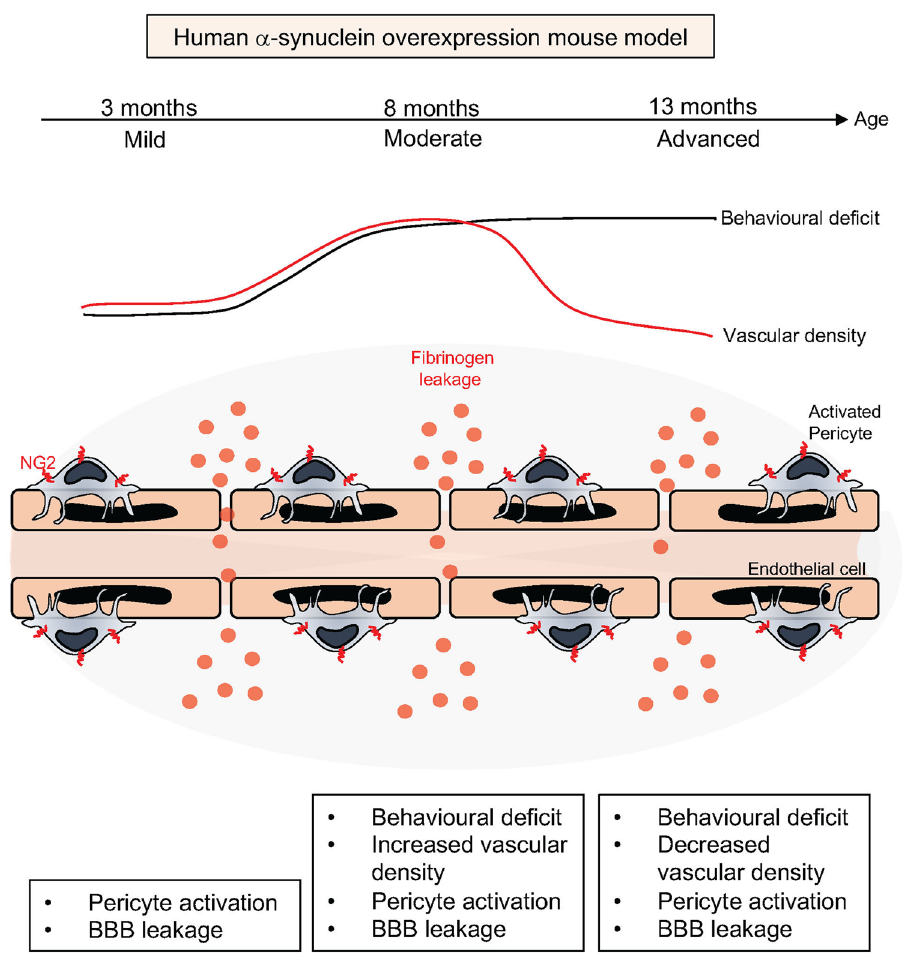
Figure 9. Summary of the key findings. Human α-syn overexpression mouse model displays early blood– brain barrier leakage, stage-dependent dynamic changes in vessel morphology and pathological activation of